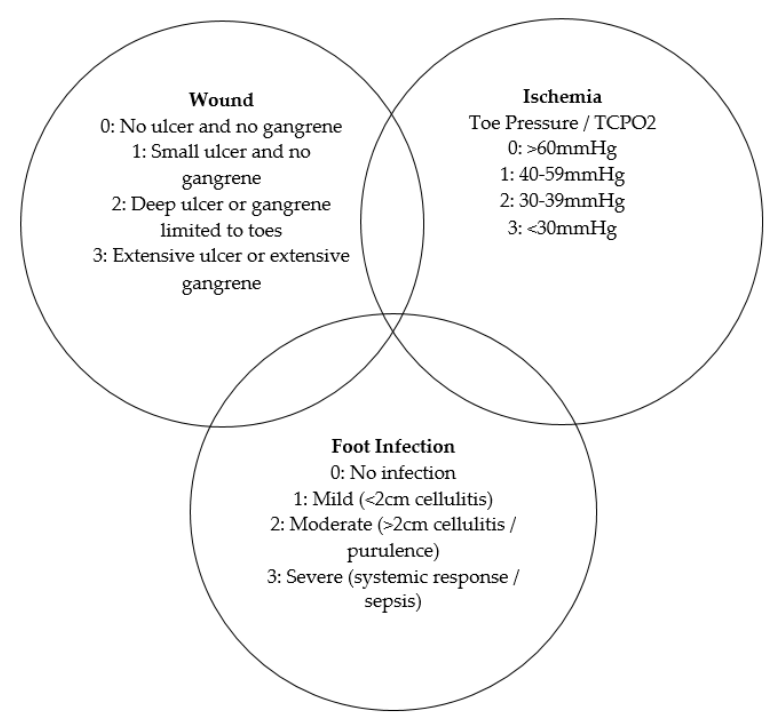
Figure 2. The three intersection rings of the WIfI scoring system to help identify which risk is dominant at a given time